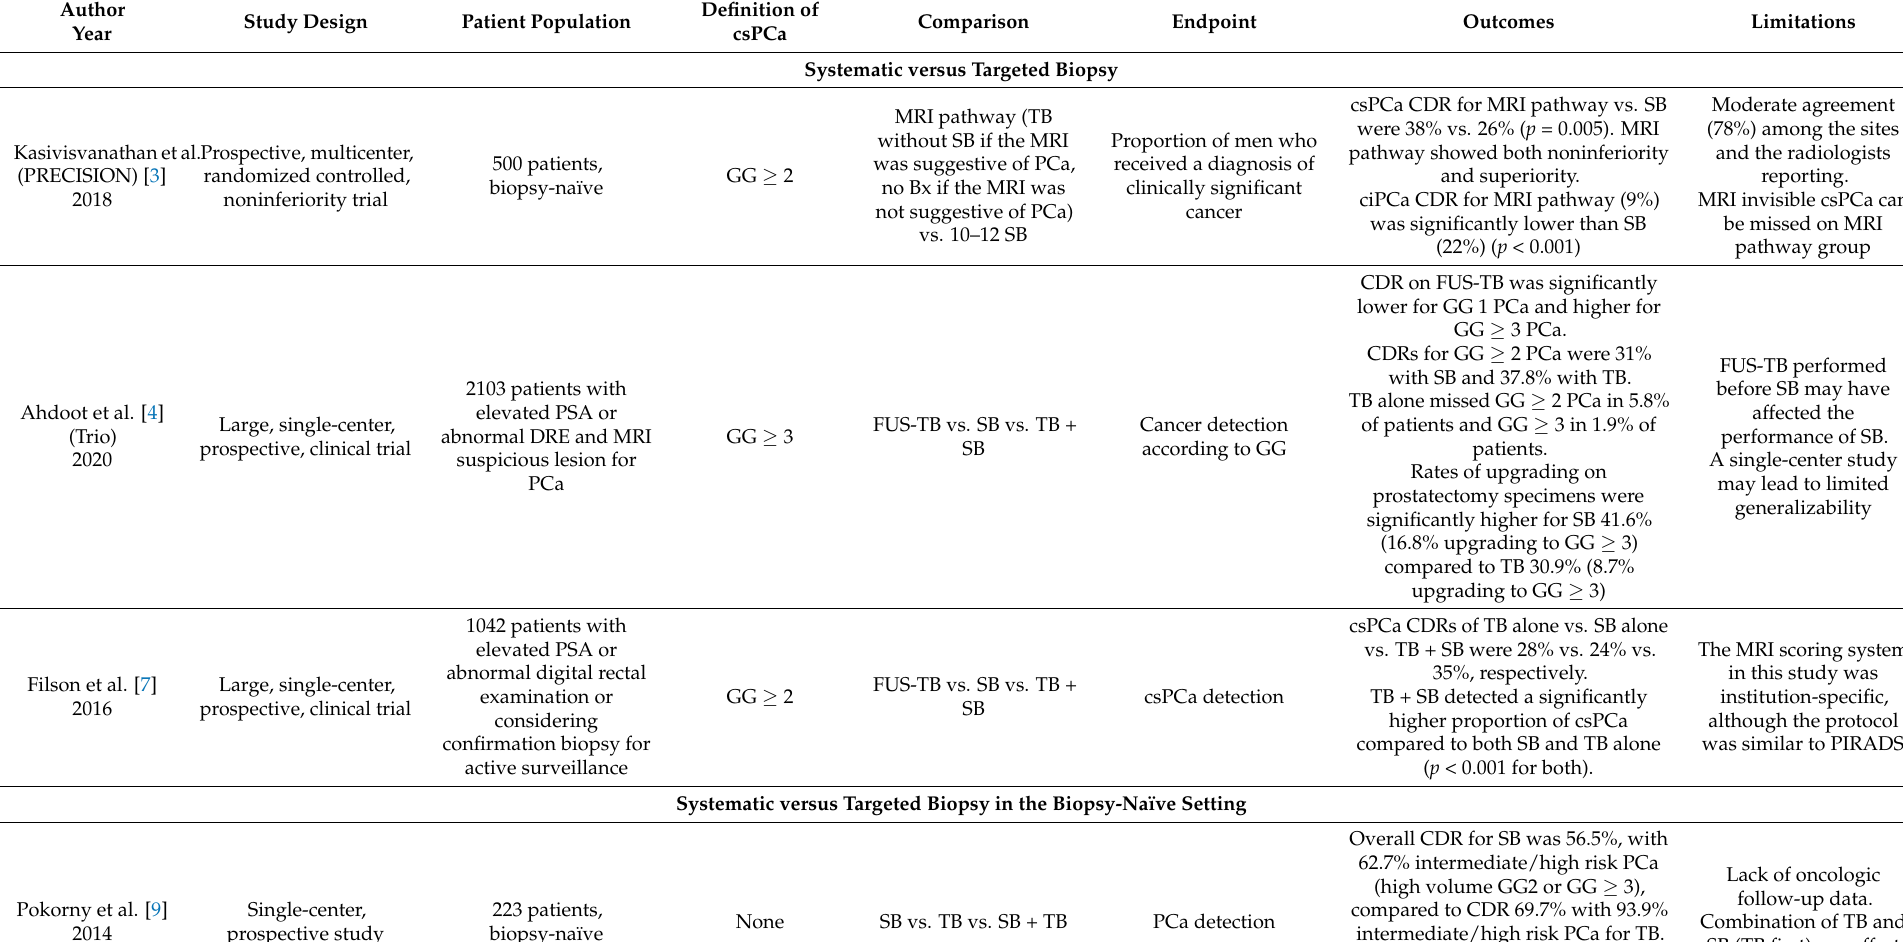
Table 1. Summary of high-impact manuscripts reviewed in this